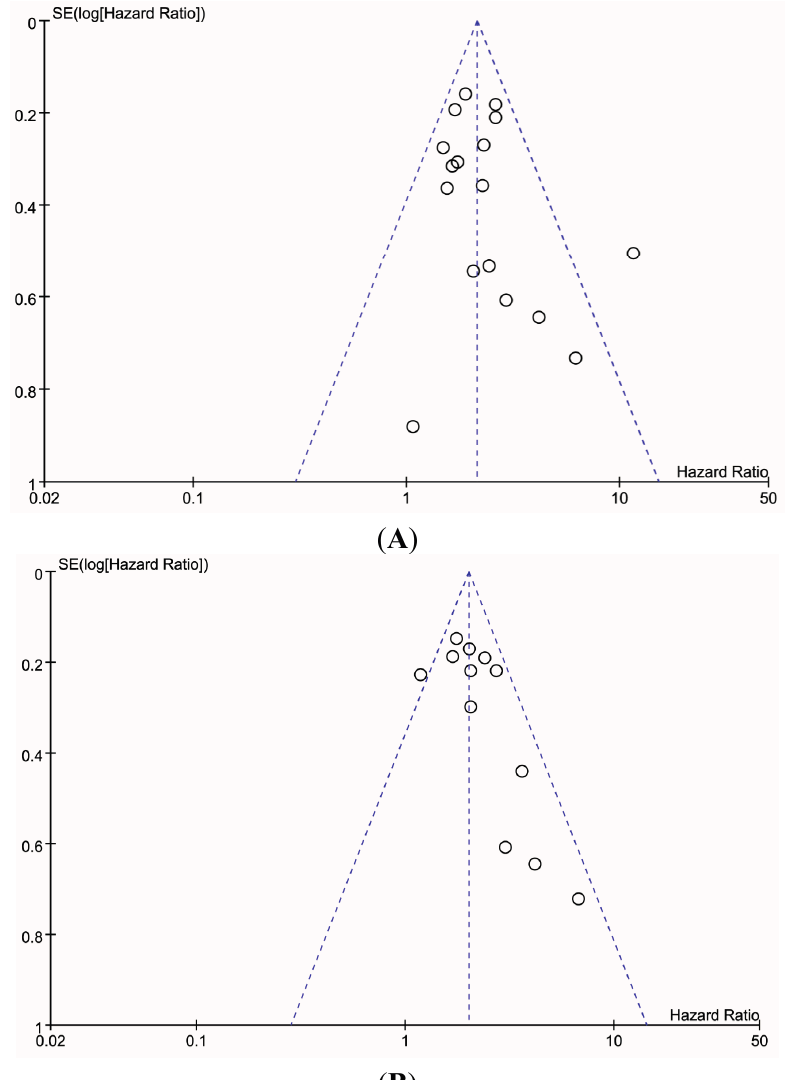
Figure 2. Funnel plot analysis to detect publication bias. Each point represents a separate study for the indicated association and the horizontal axes represent the hazard ratio with 95% confidence limits and vertical axes represent standard error of logarithmic hazard radio. ( A , B ) funnels plot for 3-year OS and 5-year OS,